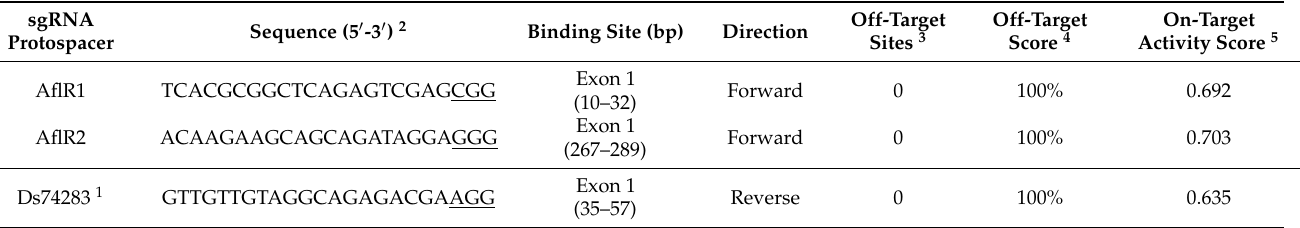
Table 1. CRISPR/Cas9 sgRNA protospacers used to target for Dothistroma septosporum AflR and Ds74283